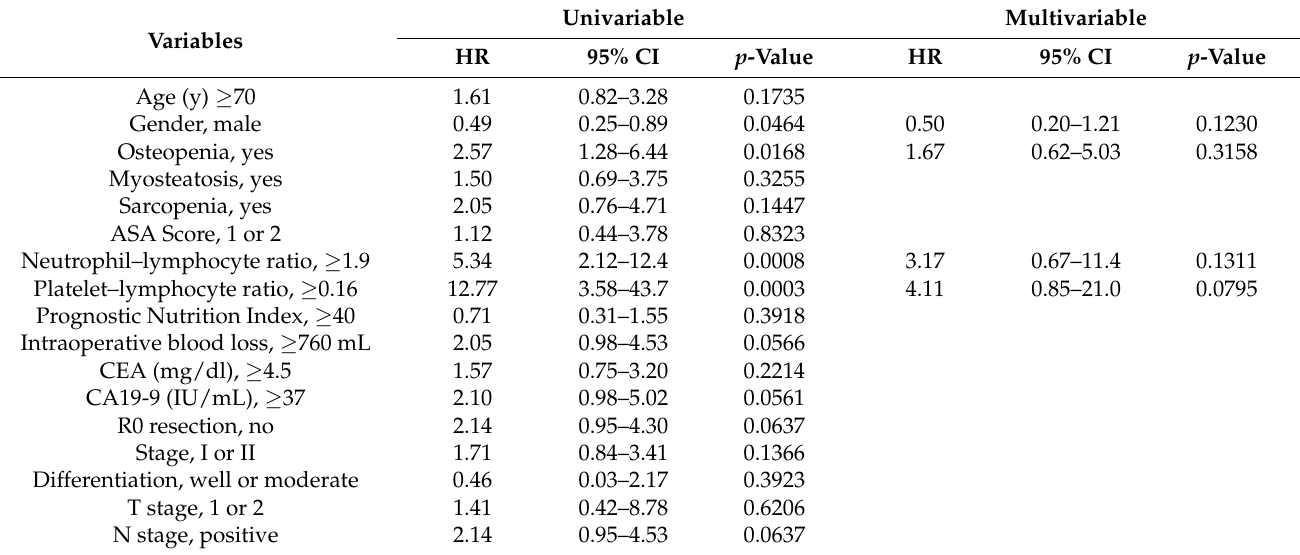
Table 3. Univariable and multivariable analysis for recurrence-free